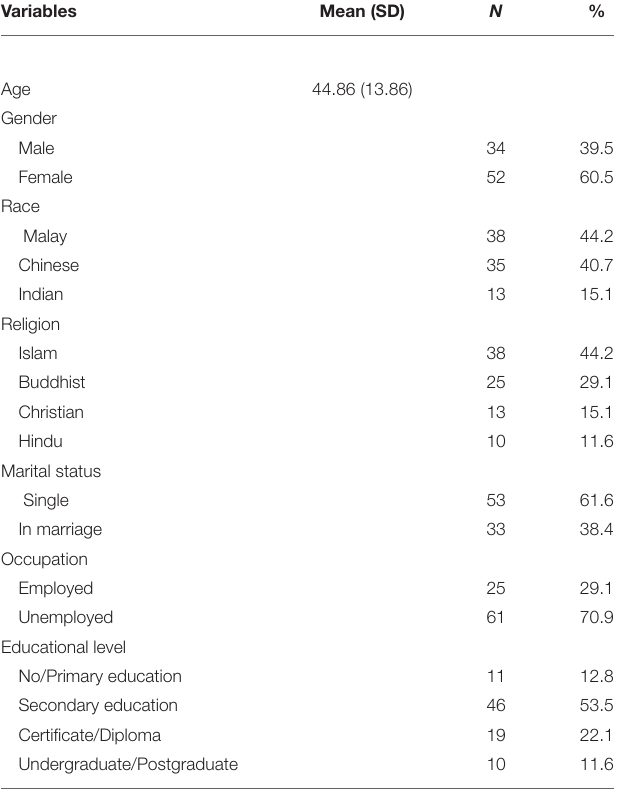
TABLE 1 | Sociodemographic characteristics of respondents ( N = 86). Variables